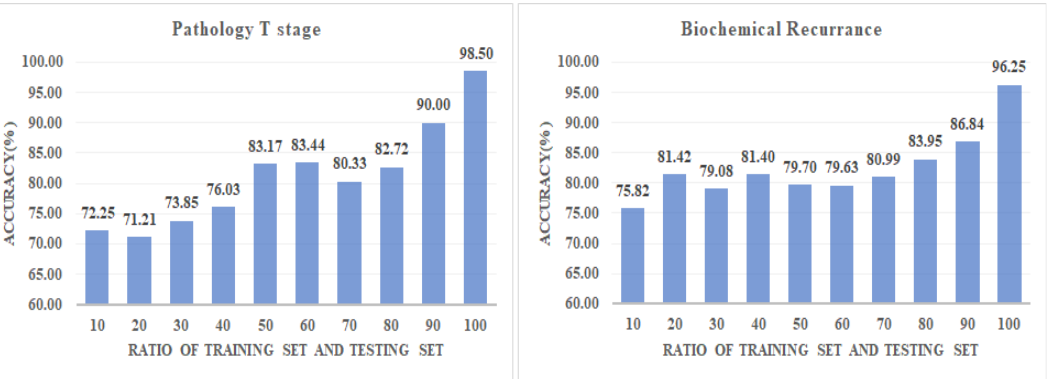
Figure 9. Results of the predictions of pathological T stage and BCR ( left : pathological T stage; right : biochemical recurrence).